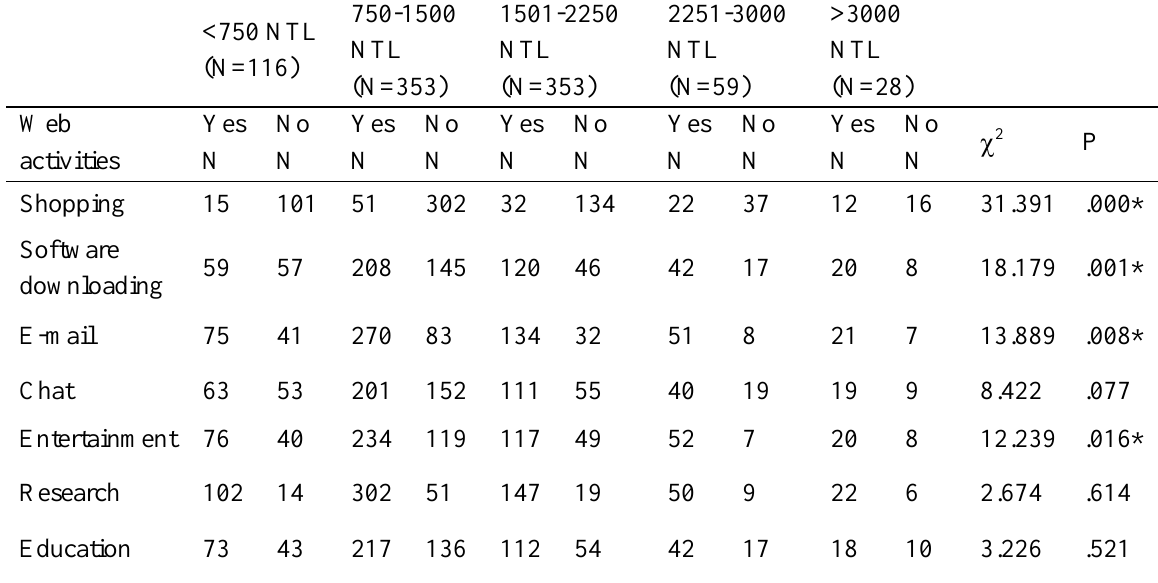
Differences in Using the Web for the Common Web Activities Based on Monthly Family Incomes in New Turkish Lira